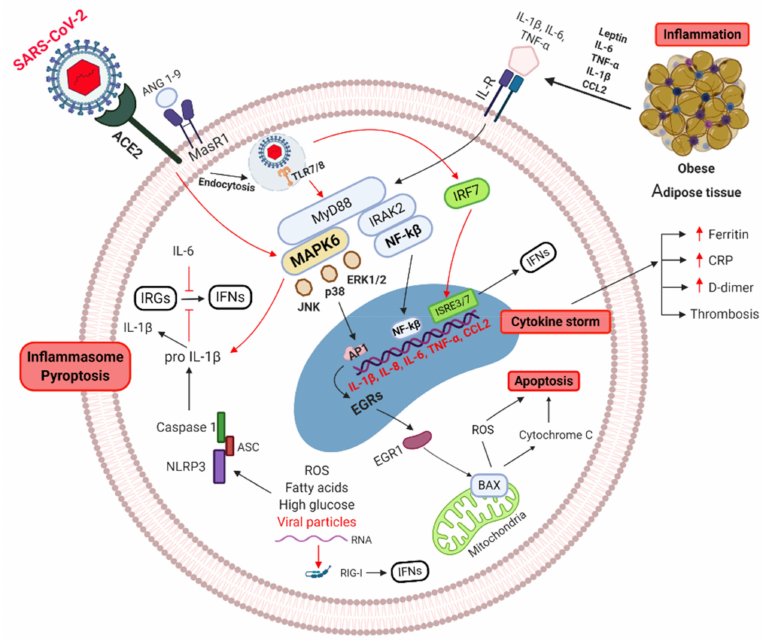
Figure 2. Signaling pathways of obese/T2D cell, of critical COVID-19 cases. Obese and T2D patients have already activated inflammatory pathways. SARS-CoV-2 entry though ACE2 receptor, can alters ACE2/MasR1 axis inducing MAPK6 activation, triggering pyroptosis with high IL-1 production (cytokine storm). Uptake of viral antigens by intracellular Toll Like Receptors (TLR 7/8) can signal through NF- κ B pathway, resulting in more inflammatory cytokine production (IL-1 β , IL-6, IL-8, IL-18, CCL-2, and TNF- α ) (cytokine storm). In addition, viral RNA can induce NLRP3 activation resulting in secretion of IL-1 β (inflammasome), leading to further activated inflammation. Excessive inflammatory cytokines (IL-1/IL-6) can block IFN type 1 production. MAPK: mitogen-activated protein kinase, IL: Interleukins, ILR: Interleukins receptor, TNF: Tumor necrosis factor, BAX: BCL2- associated X genes, JNK: c-Jun N-terminal kinase, IRAK-2: Interleukin-1 receptor-associated kinase 2, EGRs: Early response genes, NF- κ B: nuclear factor kappa B, TLR: toll-like receptor, CCL2: C-C